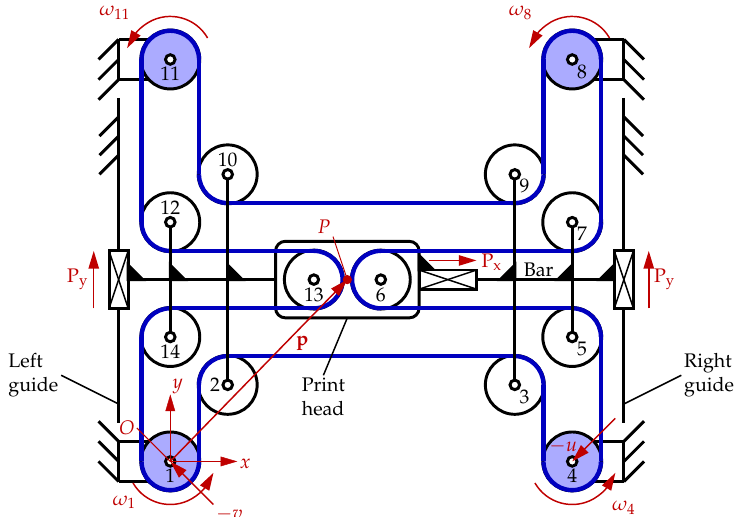
Figure 5. Schematic of a CoreH-bot (top view). Only one belt is used, as in the H-bot; the four actuated pulleys are colored. The coordinate frame F = ( O , x , y , z ) has origin at the center of pulley 1 (on the lower left); the pulleys are numbered, counting along the belt, in the counterclockwise direction. Unlike both the CoreXY and the H-bot, this is a closed -loop design. Thus, the mecha- nism has 3 DoFs: two translations of the print head (along the x and y axes) and one DoF corresponding to the idle rotation of the belt over the pulleys (while the print head